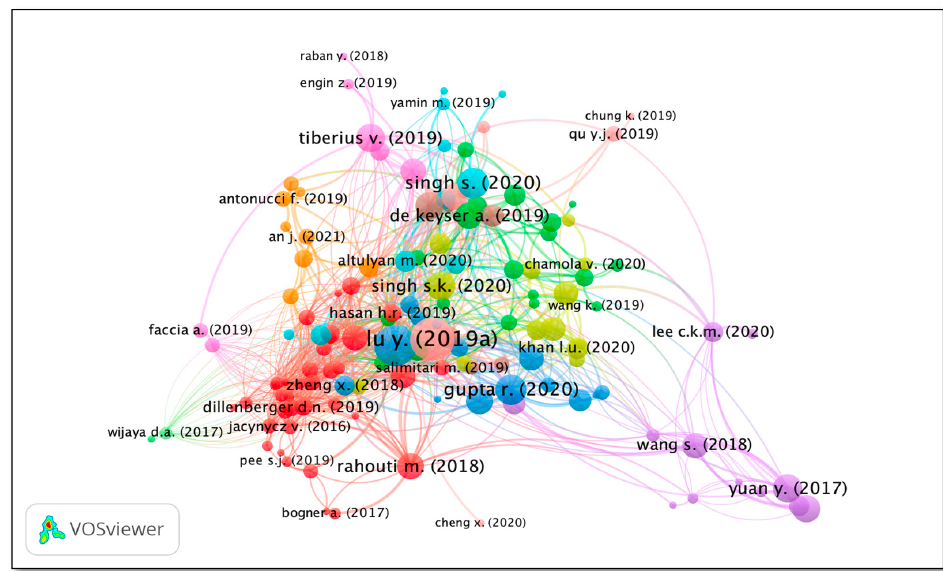
Figure 17. Bibliographic coupling of documents.